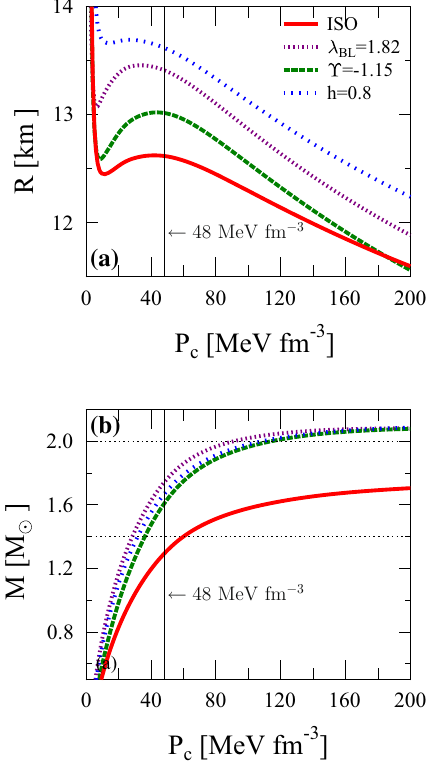
Fig. 6 Impact of anisotropic pressure for all models used on a radius and b mass profiles of NS with hyperons as a function of NS central pressure. The Vertical line in P c =48 MeV fm − 3 is a marker when the hyperons start to